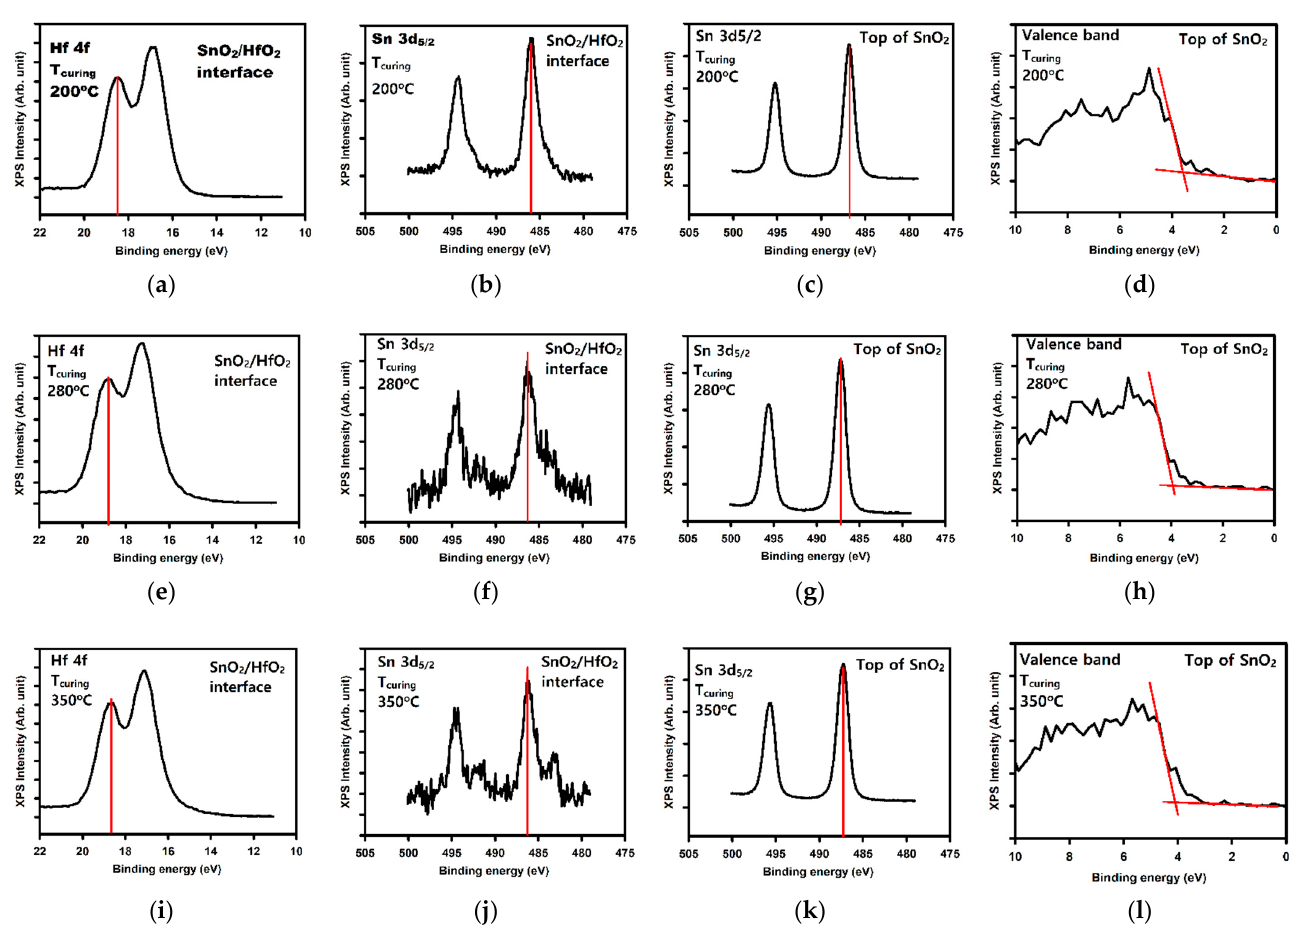
Figure 5. XPS analysis used for the calculation of the band offsets for the various SnO 2 curing temperatures. ( a , e , i ) the Hf 4f at the interface of SnO 2 /HfO 2 , ( b , f , j ) the Sn 3 d 5/2 peak at the SnO 2 /HfO 2 interface, ( c , g , k ) the Sn 3 d 5/2 at the top of the SnO 2 surface, ( d , h , l ) the valence band of SnO 2 at the top of the SnO 2 surface. The first second, and third line shows the peaks for the SnO 2 thin film cured at 200, 280, and 350 ◦ C respectively. The peaks and curing conditions are indicated within the figures. The red lines in each graph shows the value of the peak extracted and used for the calculation of Δ E v . Table 2. Summary of the peak positions used to extract the valence band offset. All peak positions are in